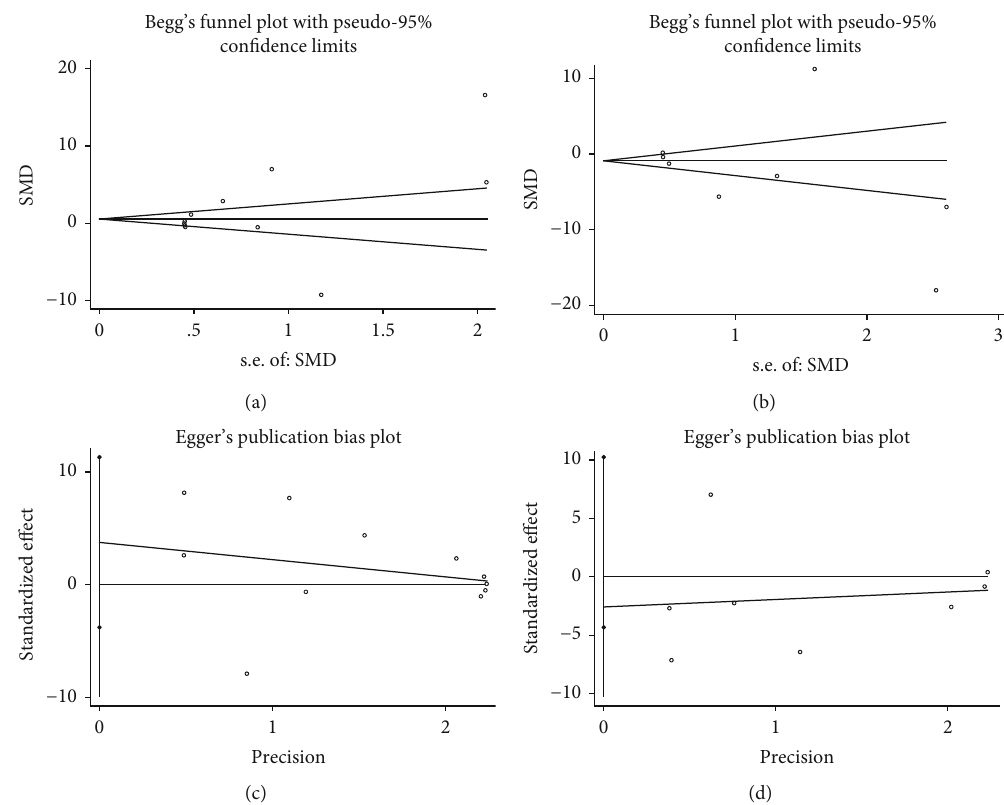
Figure 9: Assessment of publication bias in relevant studies that include Tb.N, Tb.Th, and Tb.Sp. Begg ’ s test: (a) BMSCs vs. OVX control and (b) BMSCs vs. sham control; Egger ’ s test: (c) BMSCs vs. OVX control and (d) BMSCs vs. sham